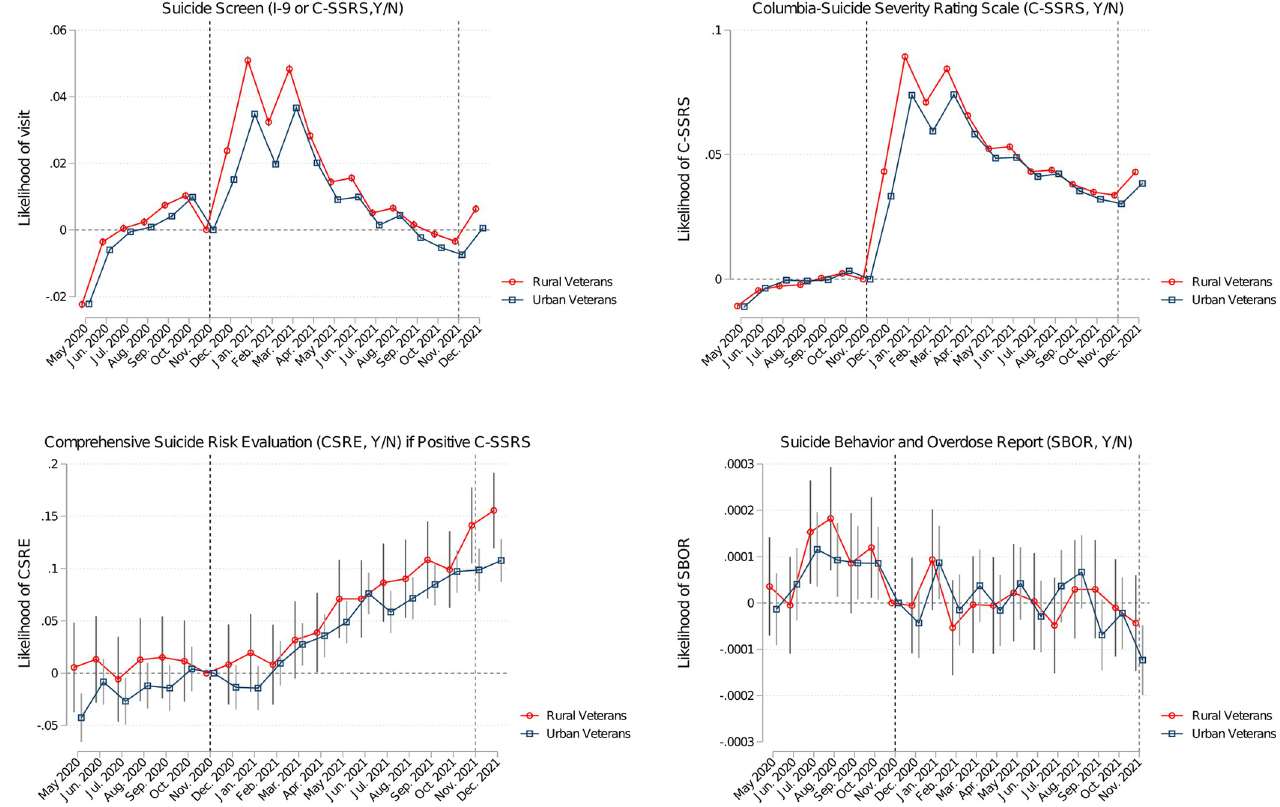
Fig 3. Model-adjusted outcome differences compared to Nov. 2020, for rural and urban Veterans–monthly coefficients from regression analyses. Note: Rural (urban) cohort analyses not conditioned on positive C-SSRSs included 485,592 (1,168,588) Veterans and 9,711,840 (23,371,760) Veteran-monthly observations. Rural (urban) cohort conditioned on positive C-SSRSs included 15,097 (42,576) Veterans and 21,040 (64,197) Veteran-monthly observations. All models adjusted for Veterans’ age, sex, race, ethnicity, number of physical and mental health chronic conditions, diagnoses of substance use disorder, post- traumatic stress disorder and depression, nosos score, VA priority-based enrollment, marital status, homelessness indicator, high suicide risk indicator, cumulative monthly COVID-19 cases in the patient’s county. All models included indicators for patients’ closest facility to control for any time-invariant facility characteristics. In sensitivity analyses, models also adjusted for broadband coverage in patients’ residential